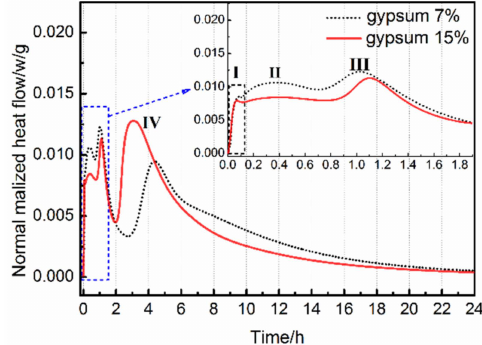
Figure 5. E ff ects of gypsum dosage on hydration of